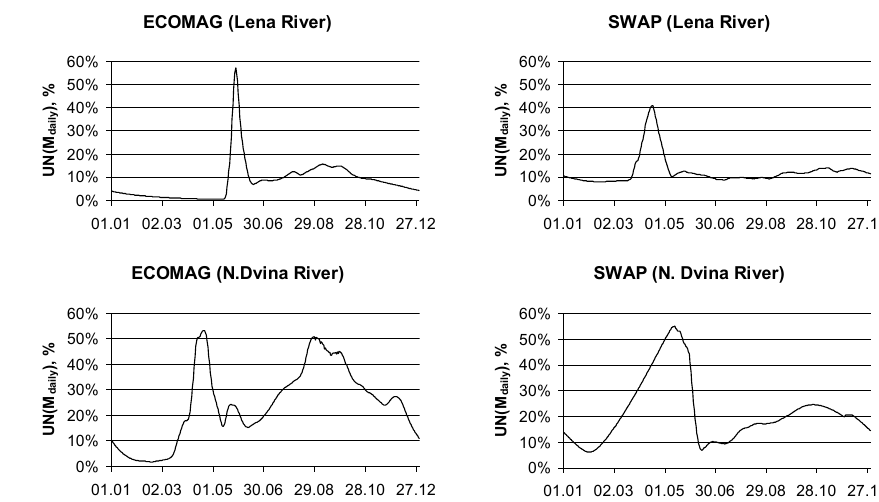
Figure 4. Intra-annual variation of uncertainty indices UN( M ) (in %) for the M estimates of daily runoff.